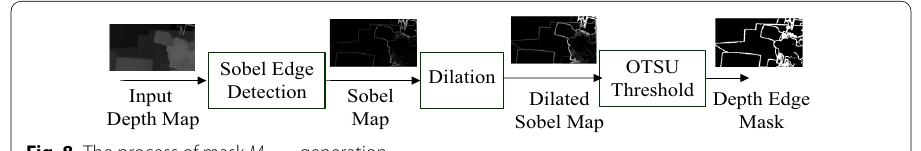
Fig. 8 The process of mask M Sobel